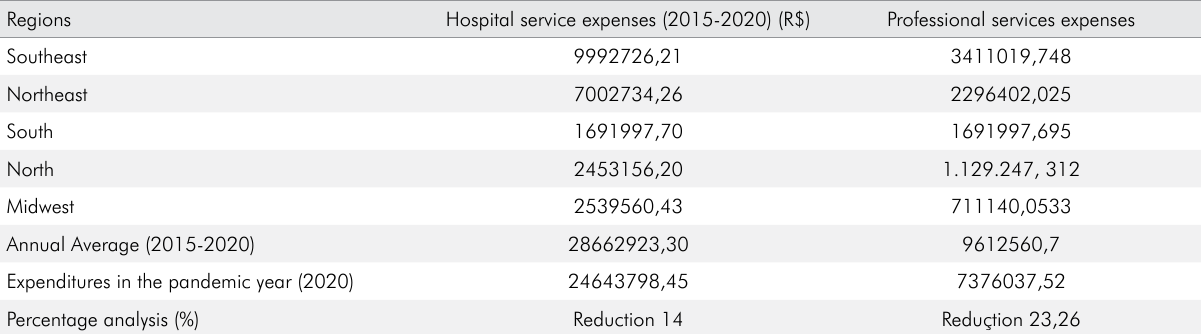
Table 3. Cost analysis for performing tertiary dental care procedures in Brazilian regions.